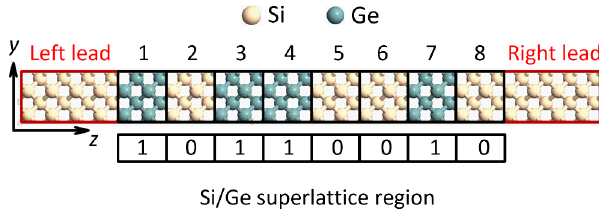
FIG. 3. Sketch of the 8-UL superlattice structure with equal numbers of Si and Ge atoms at Si-Si interface to illustrate the descriptor. Eight binary flags are used to indicate the specie of each UL ( “ 1 ” for Ge and “ 0 ” for Si), and thus, the descriptor of this structure is (10110010).